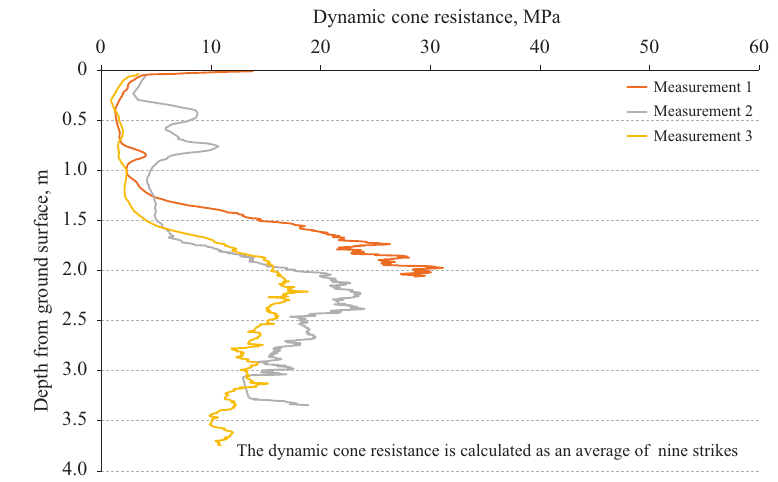
Figure 11. Measurement results for the km98 site